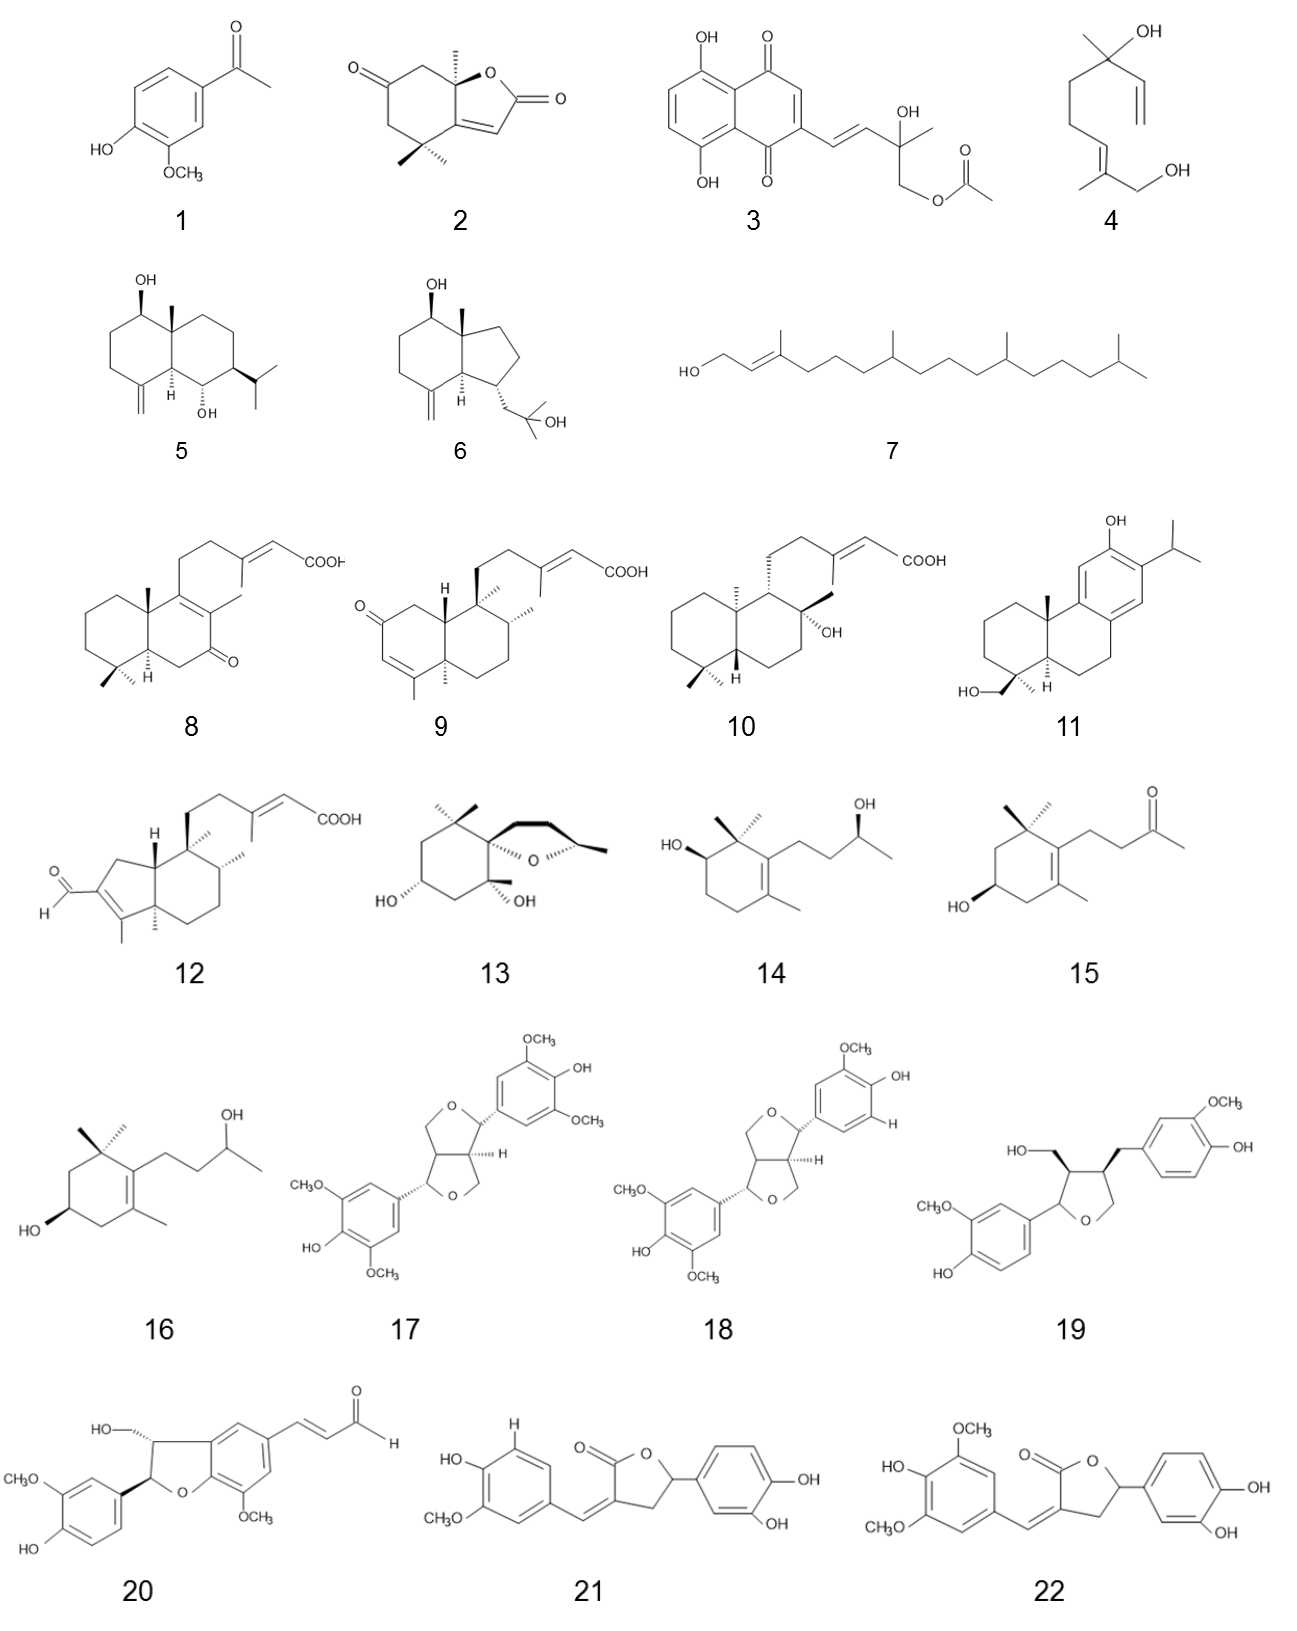
Figure 1. Phytotoxic substances in teak ．